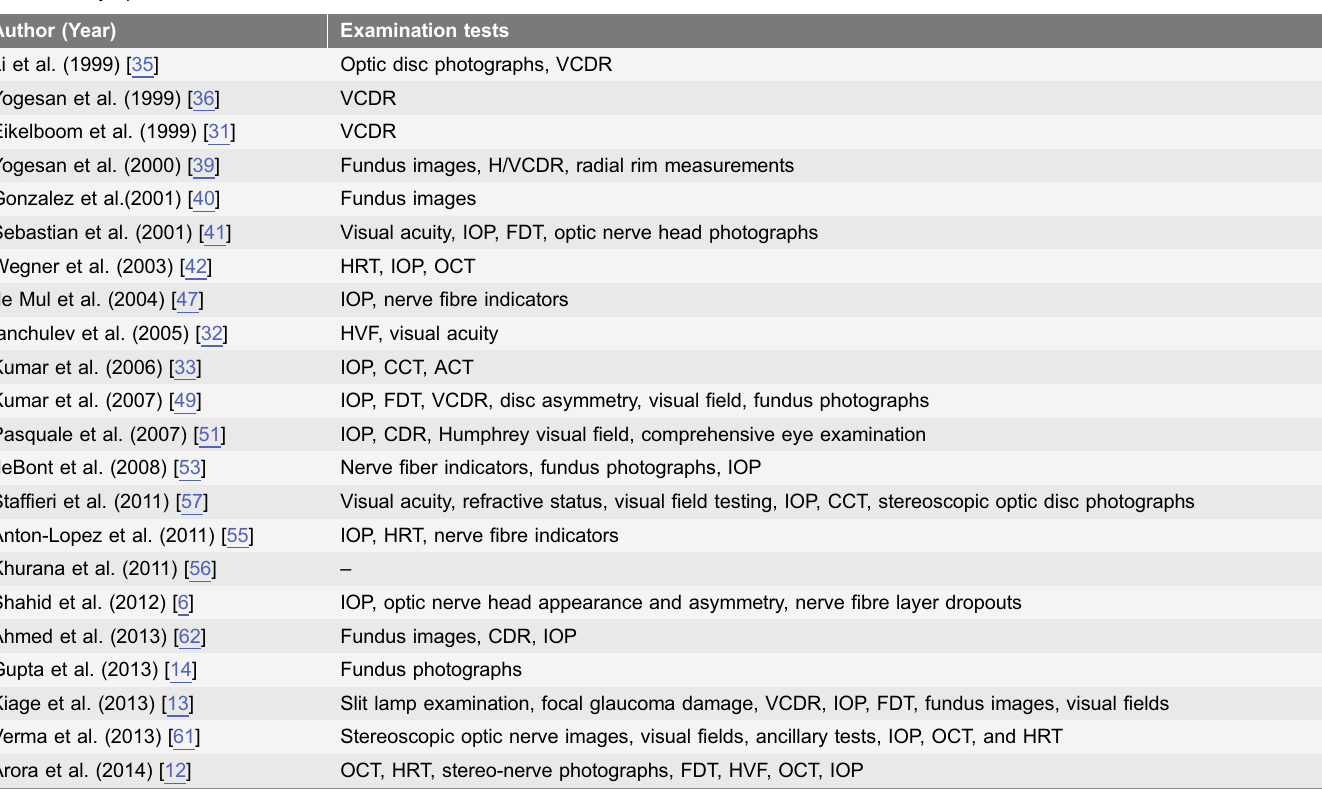
Table 8. Study ophthalmic examinations.